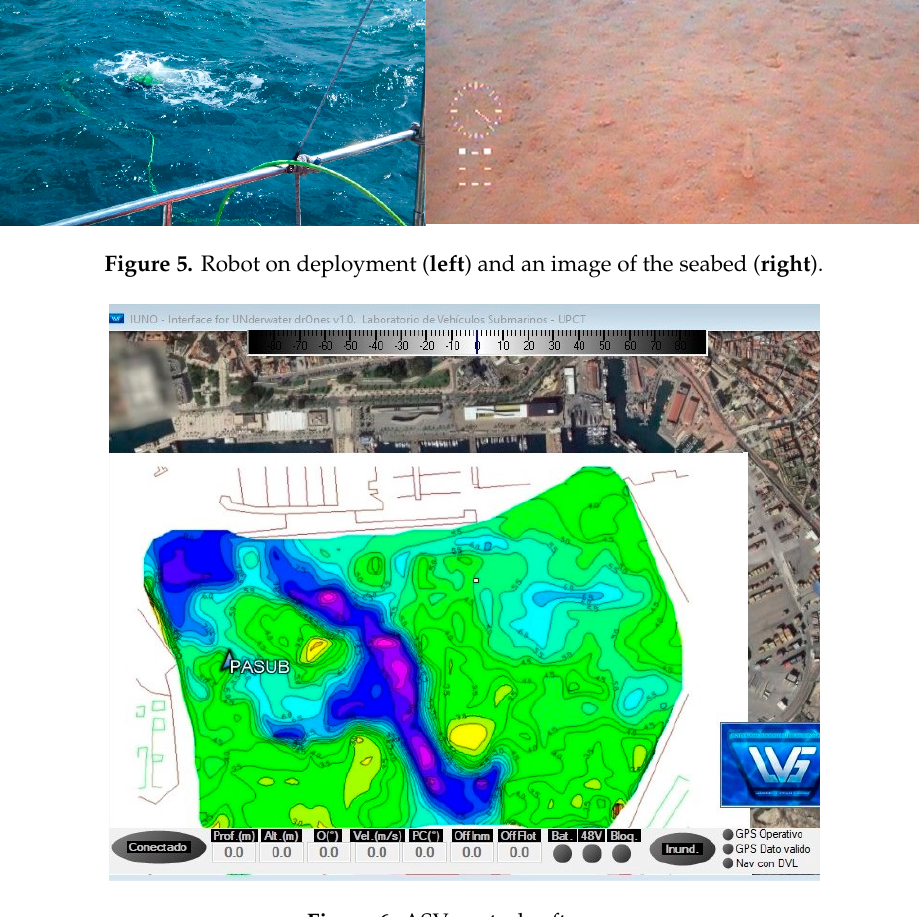
Figure 6. ASV control software.